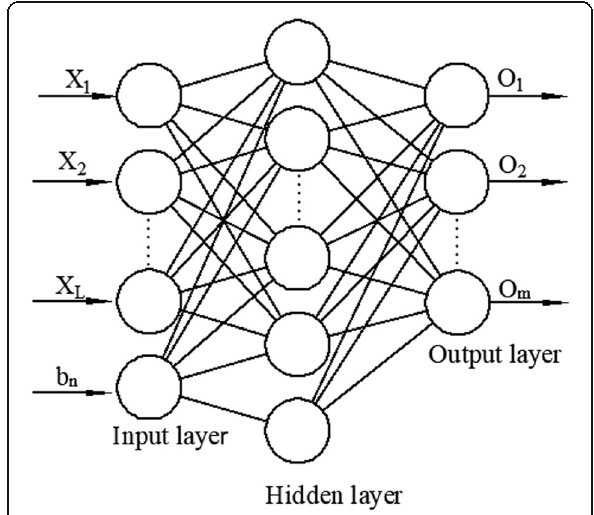
Fig. 1 Basic structure of neural network